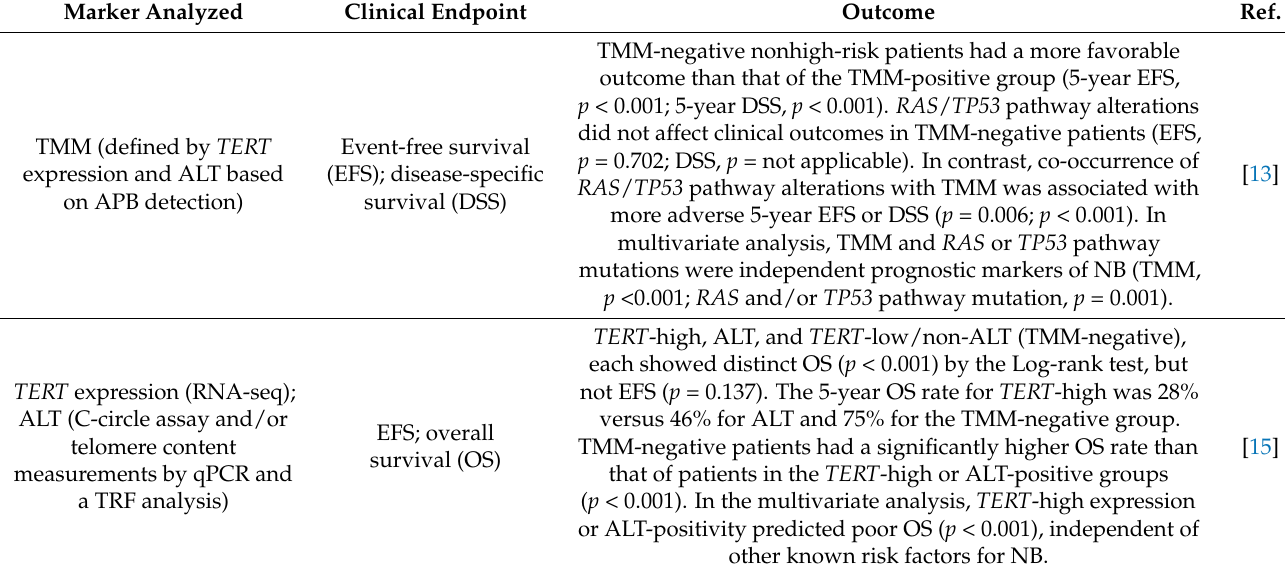
Table 2. Data reported by different studies evaluating TMM impact on clinical outcomes of